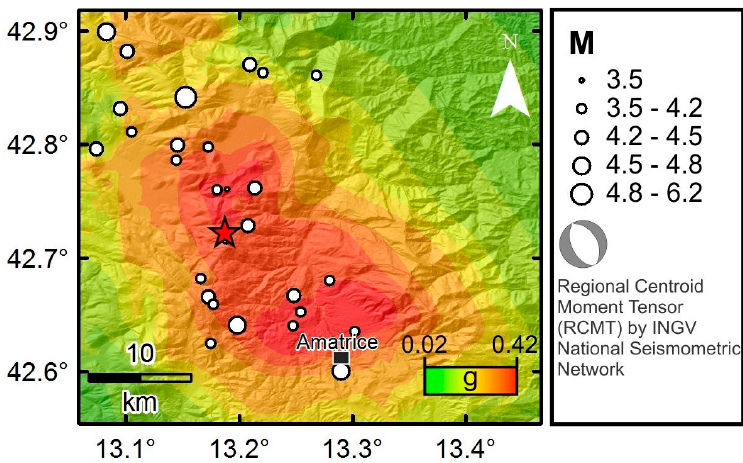
Figure 1. Distribution of aftershocks and the main shock M 6.2 (red asterisk) overlaid with a PGA map provided by the Istituto Nazionale di Geofisica e Vulcanologia (INGV). The focal mechanism indicates normal faulting in a NW–SE direction.